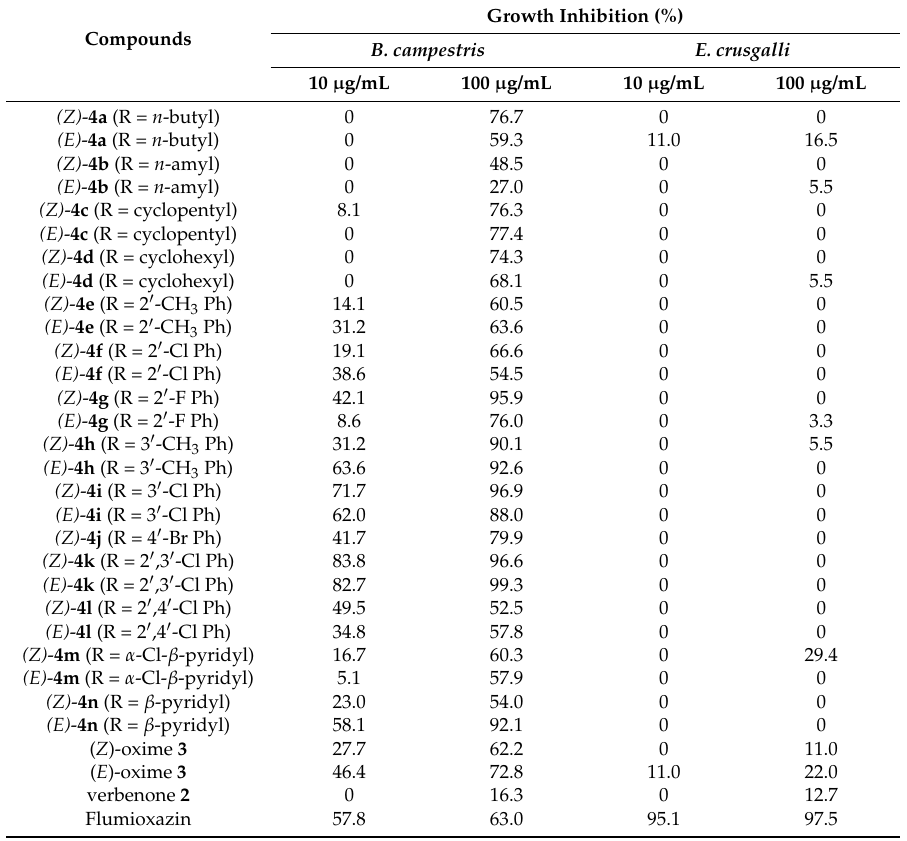
Table 2. Herbicidal activity of the target compounds ( Z )- and ( E )- 4a – 4n at 10 µ g/mL and 100 µ g/mL.